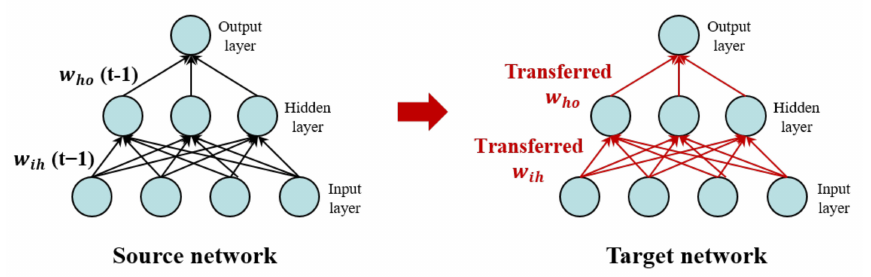
Figure 7. The schematic diagram of the incremental (INC) learning based on multi-layer perceptron. The weights trained before of source network ( w ih ( t − 1 ) and w ho ( t − 1 ) ) are transferred to the target